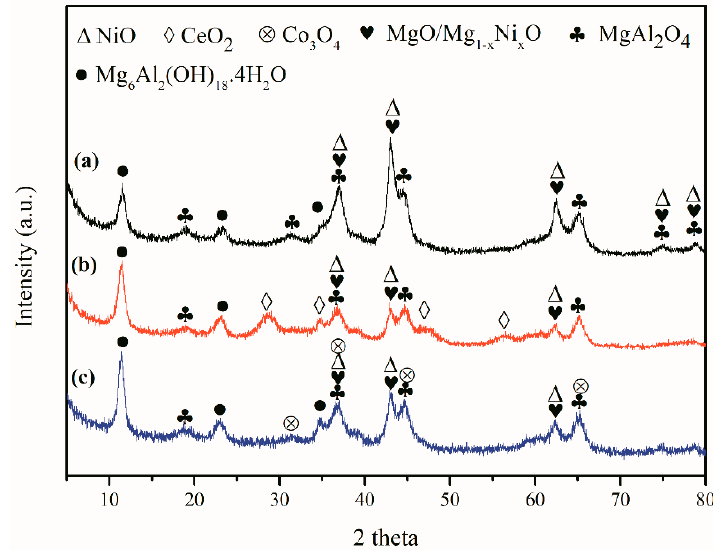
Figure 1. Powder XRD patterns of fresh 10Ni/MA (a), 5Ni5Ce/MA (b), and 5Ni5Co/MA (c) catalysts.